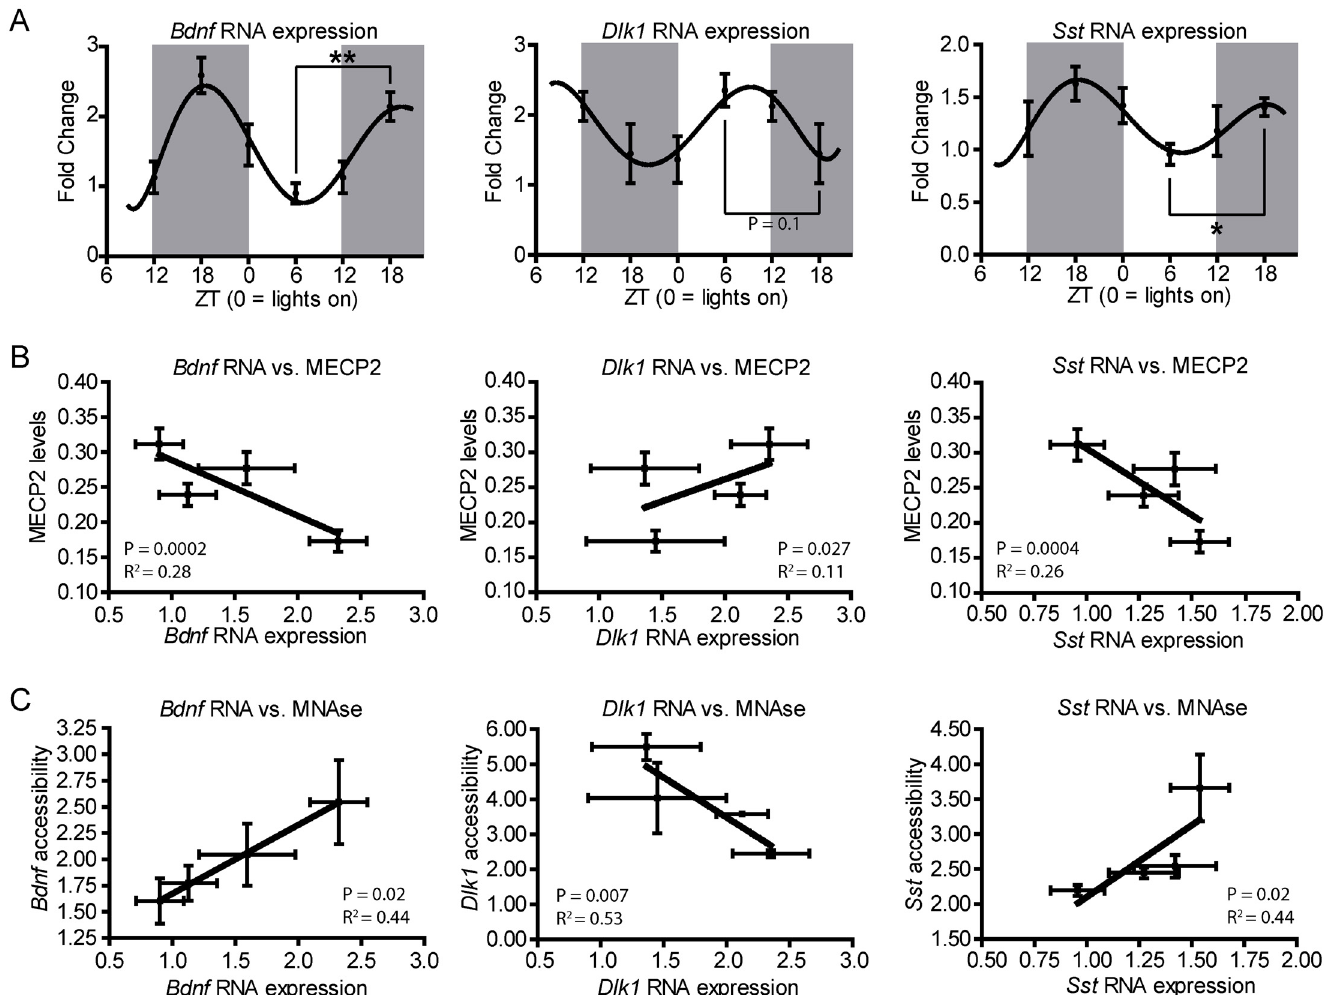
Fig 3. MeCP2-targets expression patterns also exhibit circadian changes. (A) RT qPCR analysis demonstrates gene expression changes along light- dark cycles (n = 3 – 5 mice/time point; graphs show mean ± SEM). (B) Correlations between MeCP2-targets expression with MeCP2 protein levels as well as (C) with the accessibility to the corresponding promoters. * P < 0.05, ** p < 0.005 in two-tailed Student ’ s t -tests. Correlation p-values correspond to the linear regression